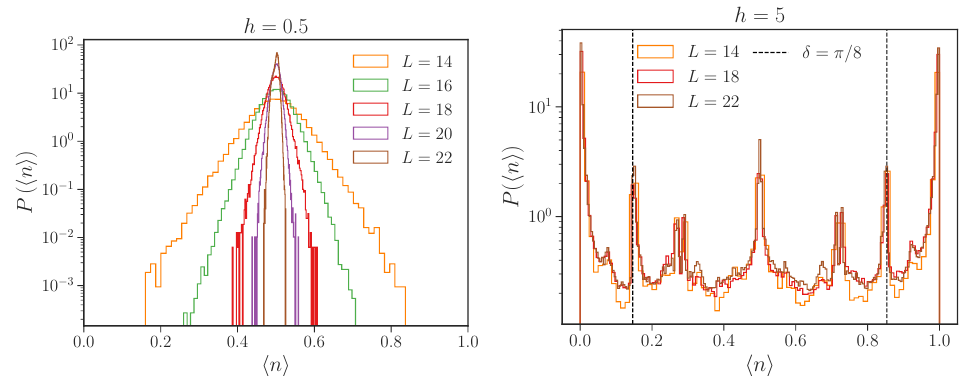
〉 ) in the thermal phase ( h = 0.5). Right: Figure 5: Left: density distribution P ( 〈 n i density distribution in the MBL phase ( h = 5). Distribution are drawn taking into ac- count all sites and states around energy density ε = 0.5. Dashed lines: 〈 n 〉 = cos 2 ( δ ) , 〈 n 〉 = sin 2 ( δ ) , δ = π/